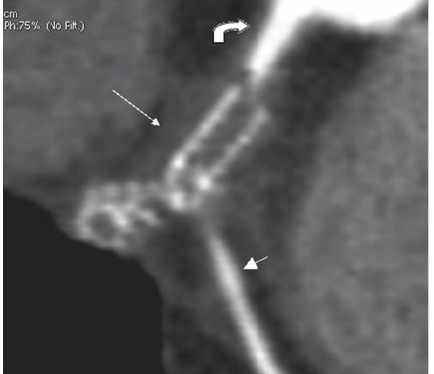
Figure 2: Hypodense fluid collection (long arrow) around the fractured stent, with perforation of RCA (curved arrow). Hypo- density suggestive of instent thrombosis is also seen. Also note good opacification of the acute marginal branch of the RCA (short